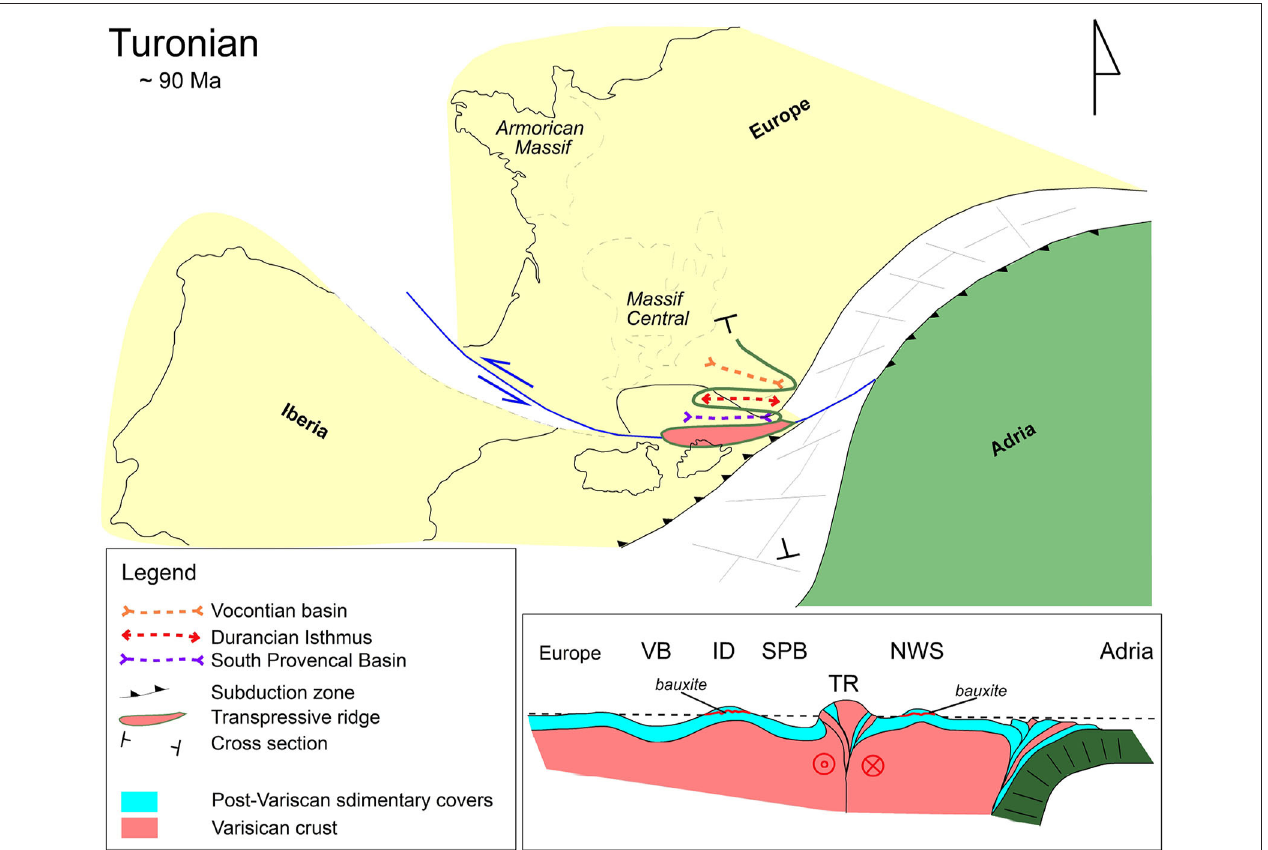
FIGURE 12 | Palaeogeographic sketch of Turonian Europe. In the schematic cross section VB, Vocontian Basin; ID, Durancian Isthmus; SPB, South Provencal Basin; TR, Transpressive Belt; NWS, North Western Sardinia and Corsica. The dotted line refers to the base level.